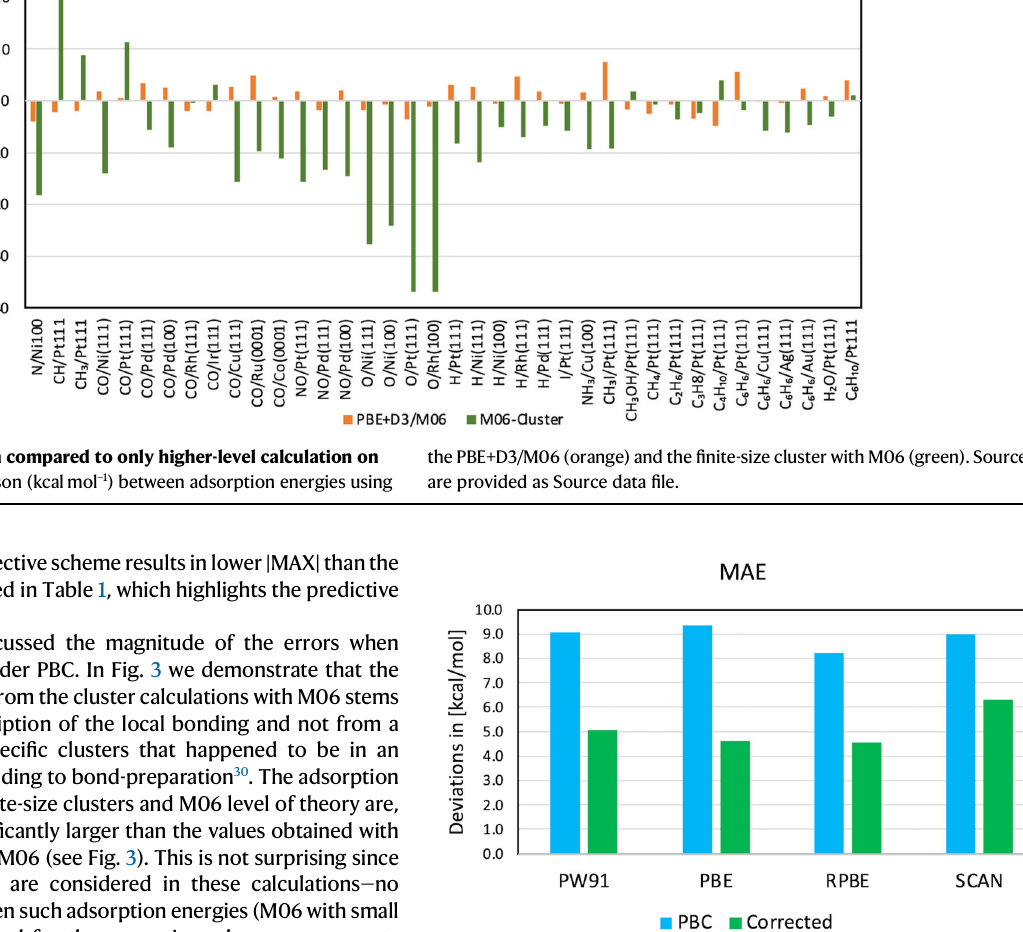
Fig. 4 | Cluster correction applied to other functionals. MAE calculated for the PBC-PW91 and corrected PW91/M06, PBC-PBE and corrected PBE/M06, PBC-RPBE and corrected RPBE/M06 and PBC-SCAN and corrected SCAN/M06 where blue correspondstotheMAEofthenon-correctedPBCadsorptionenergieswhilegreen stands for the M06 corrected cases. For all cases, the applied correction system- atically reduced the obtained MAEs. Source data are provided as Source data fi